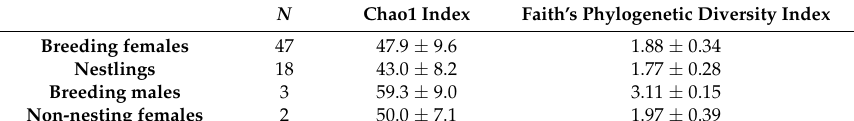
Table 1. α -Diversity indexes (Chao1 index and Faith’s phylogenetic diversity index) of the uropygial microbiota along the breeding season. Average and standard deviation are shown for different hoopoe groups (breeding females, nestlings, males and non-nesting females). N Chao1 Index